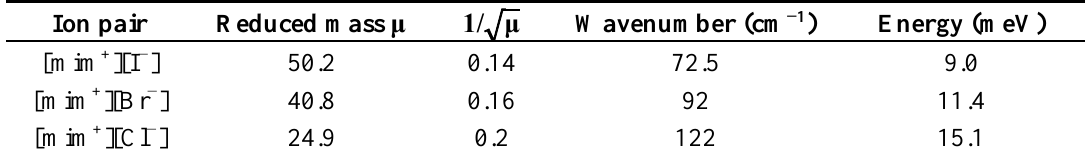
Table 1. Reduced mass μ, 1/ √ μ, wavenumber of absorption peak (cm −1 ), vibration